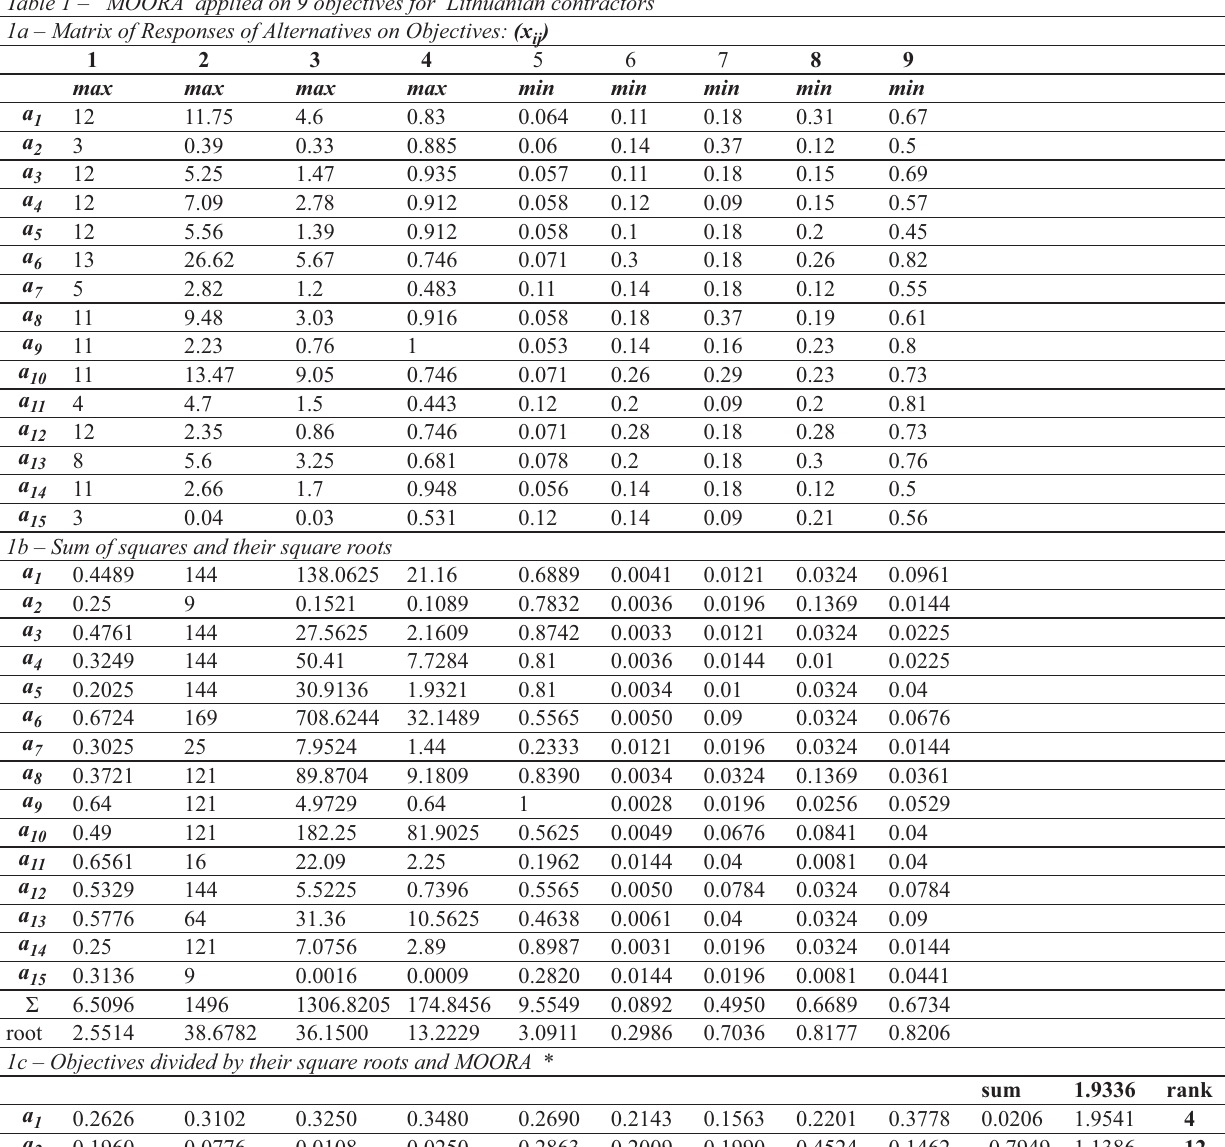
Table 1 – MOORA applied on 9 objectives for Lithuanian contractors 1a – Matrix of Responses of Alternatives on Objectives: (x